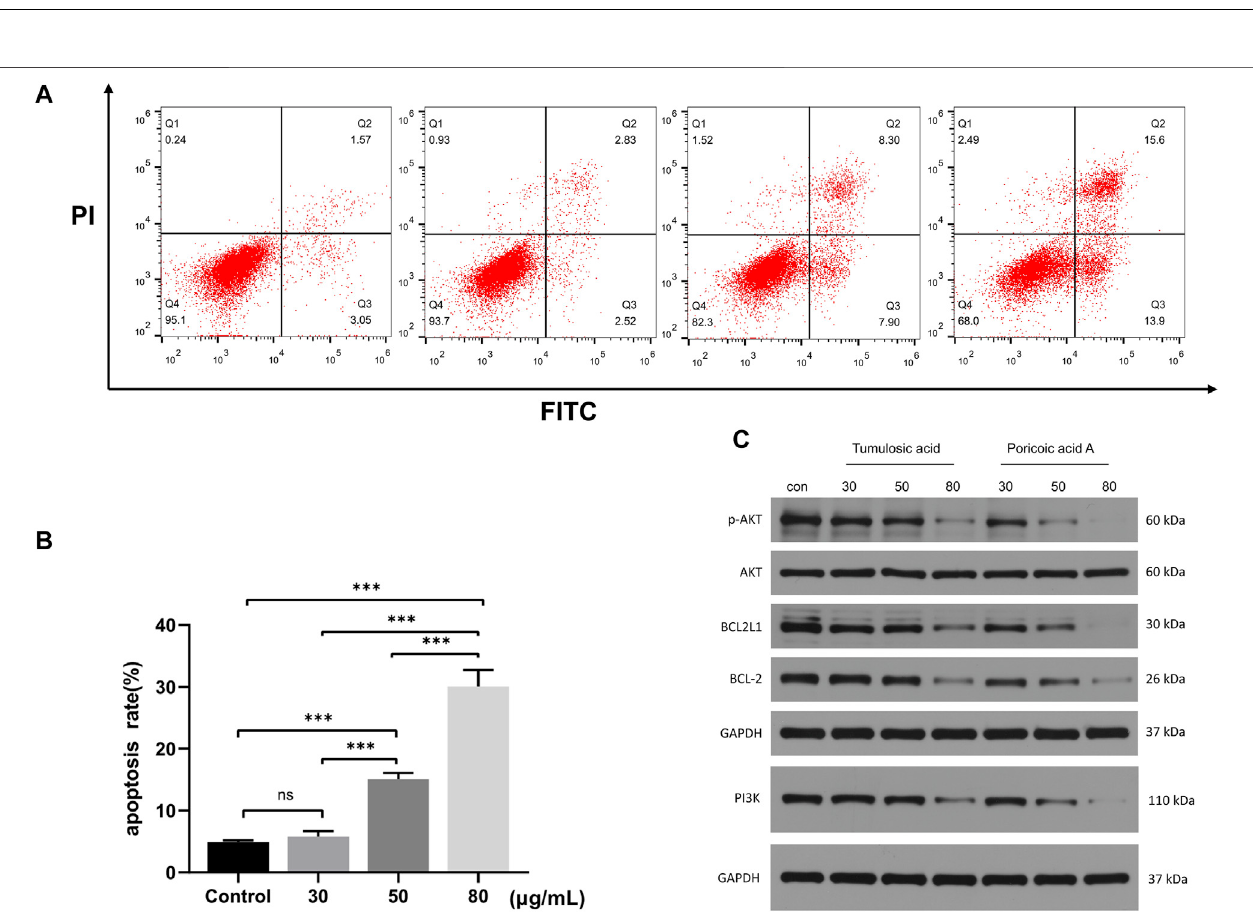
FIGURE 9| (A) SKOV3 cells were treated with various concentrations tumulosic acid. Apoptosis wasanalyzed by fl ow cytometry after Annexin V-FITC/PI staining. (B) The percentage of apoptotic cells was presented as the mean ± SD of three independent experiments, *** p < 0.01. (C) Tumulosic acid or poricoic acid A inhibits the PI3K/AKT pathway in OC cells. Representative Western blots showing the status of PI3K, AKT, p -AKT, BCL2, BCL2L1 in SKOV3.